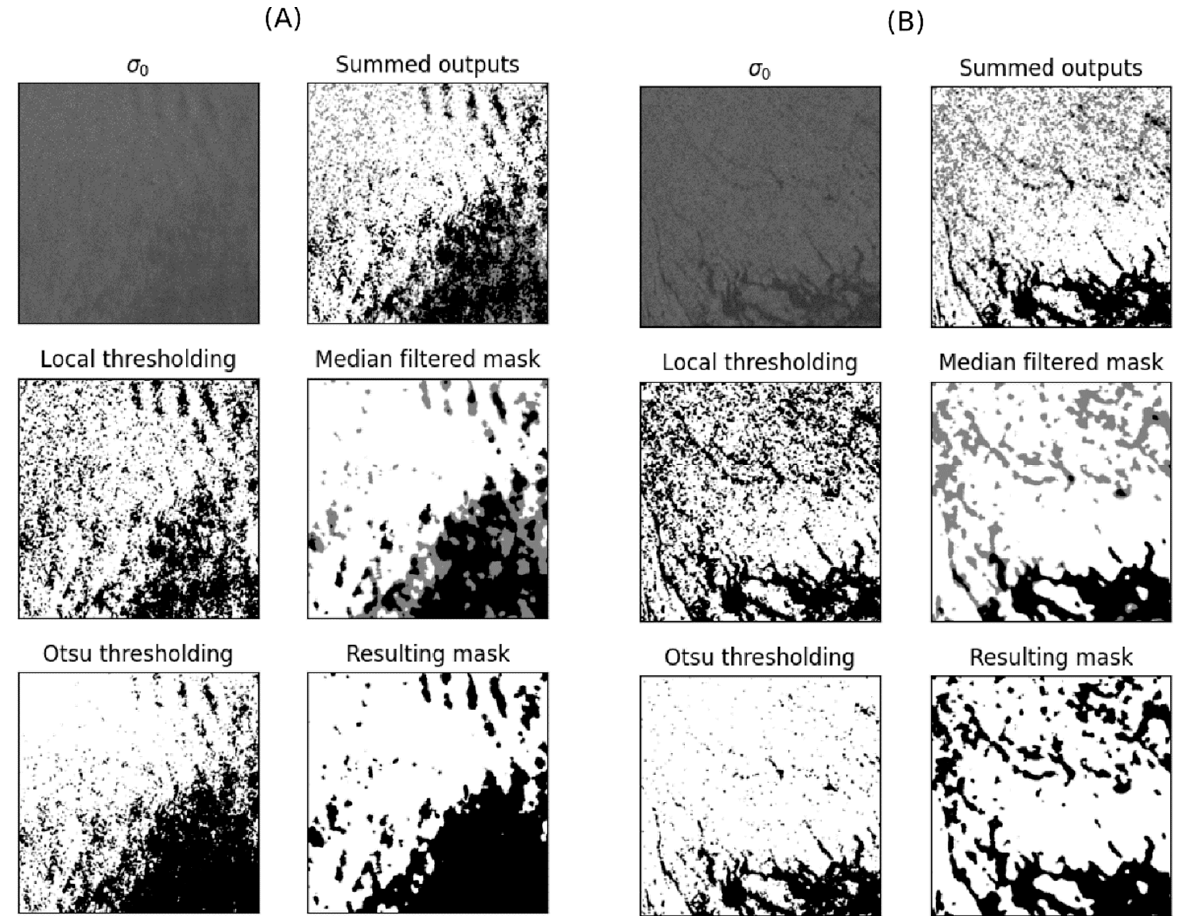
Figure 2. Segmentation methodologies applied in an SAR ( σ 0 ) image, according to the algorithms: local thresholding, the Otsu thresholding, summed outputs, and median filtered mask for Test Case 1 ( A ) and Test Case 2 ( B ).